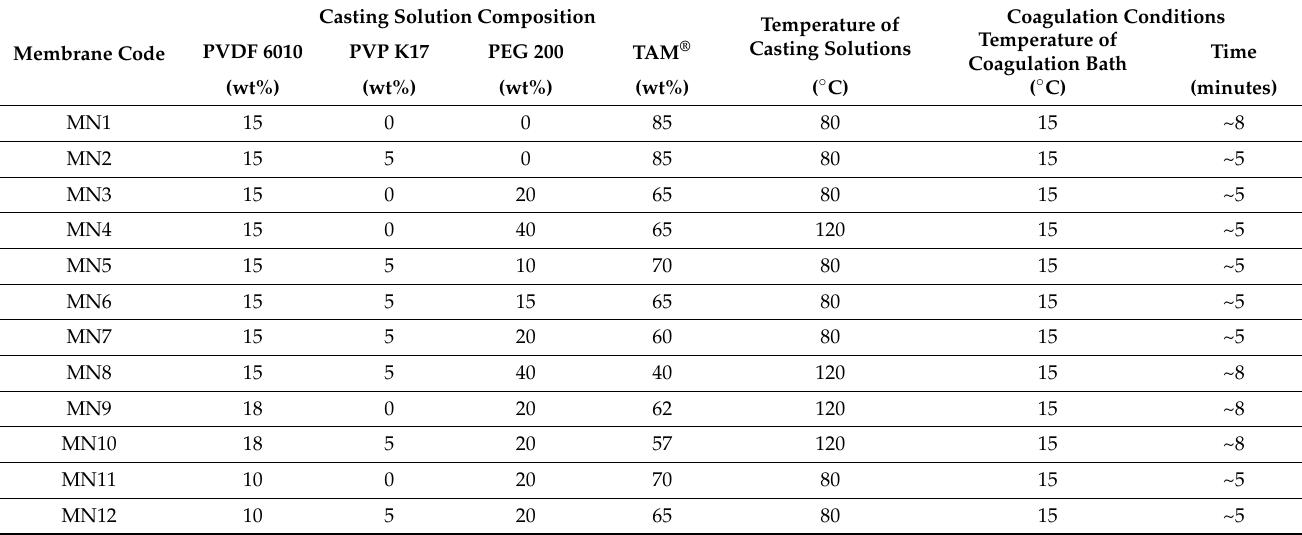
Table 2. Dope solutions compositions and investigated conditions to produce PVDF 6010 membranes.